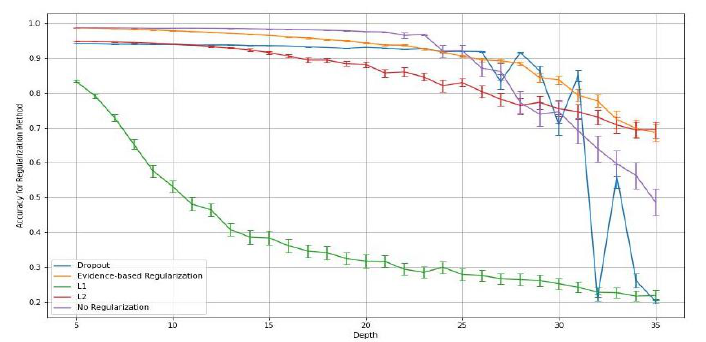
Figure A2. Training accuracy (and standard error) for different regularization methods for a network with width =